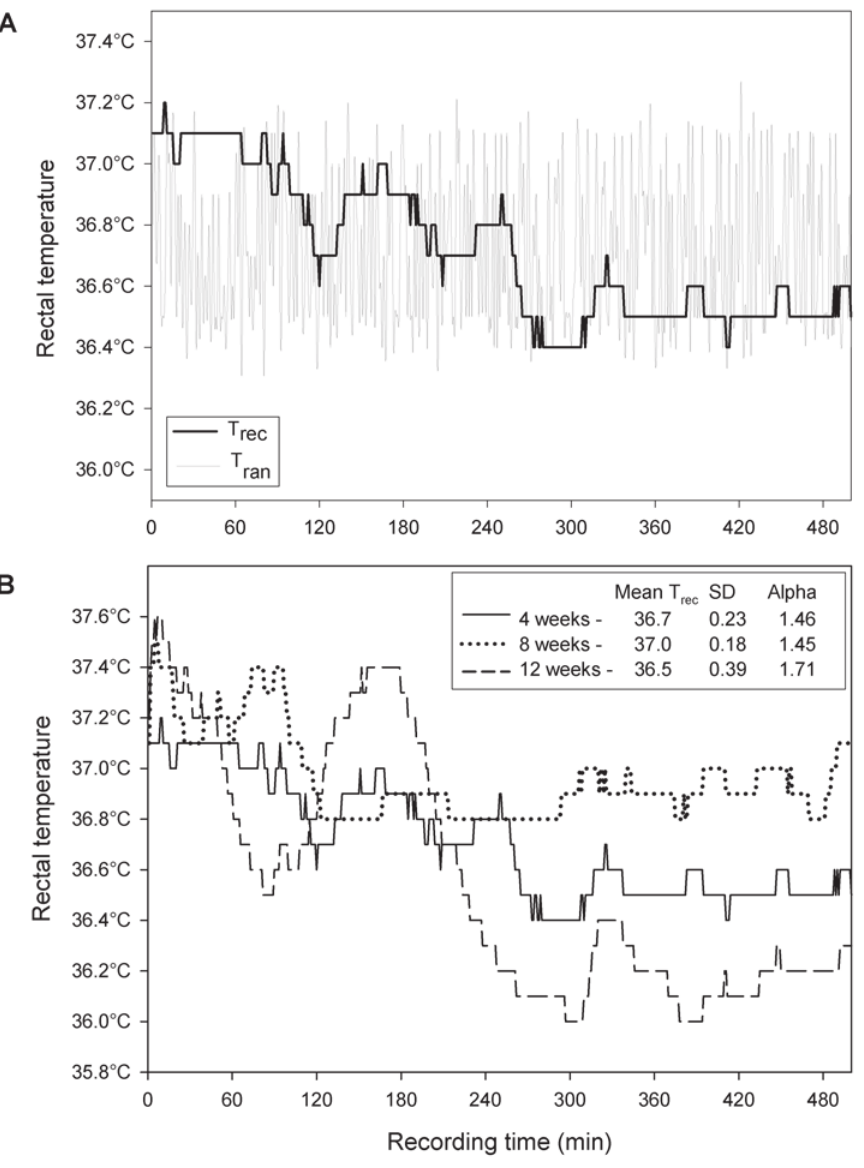
Figure 1. Night time T rec time series. a) Night time rectal temperature (T rec ) recorded over 508 minute intervals from a single infant with a mean (SD) of 37.7 u C (0.2). The corresponding random temperature (T ran ) was generated by shuffling data points of T rec . b) Longitudinal night time rectal temperature traces T rec from the same infant as Figure 1a at 4, 8, and 12 weeks with mean and standard deviation of T rec and corresponding a shown.